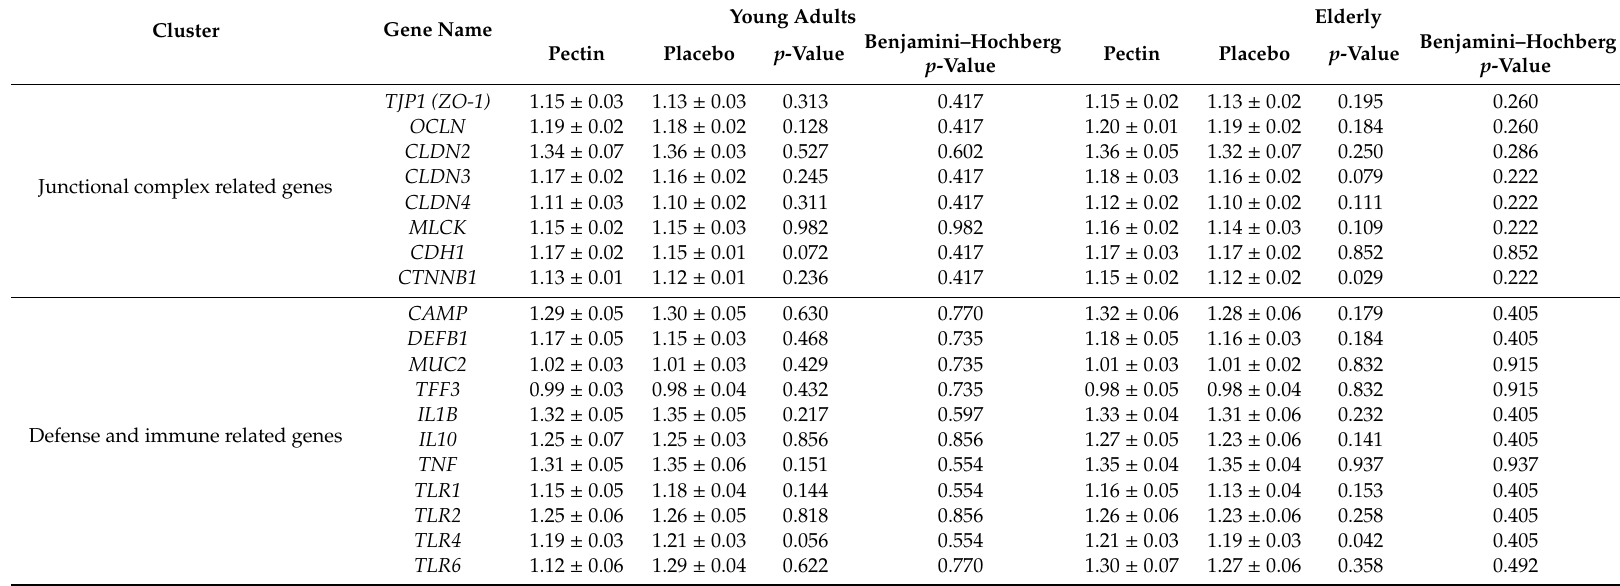
Table 2. Relative expression of junctional complexes (e.g., tight junction related and adheren junctions) and defense- and immune-related (e.g., human defensins, cytokines, and toll-like receptor) genes in sigmoid biopsies of young adults and elderly after four weeks pectin or placebo intervention. Young Adults Elderly Cluster Gene Name Benjamini–Hochberg Benjamini–Hochberg Pectin Placebo p -Value Pectin Placebo p -Value p -Value p -Value